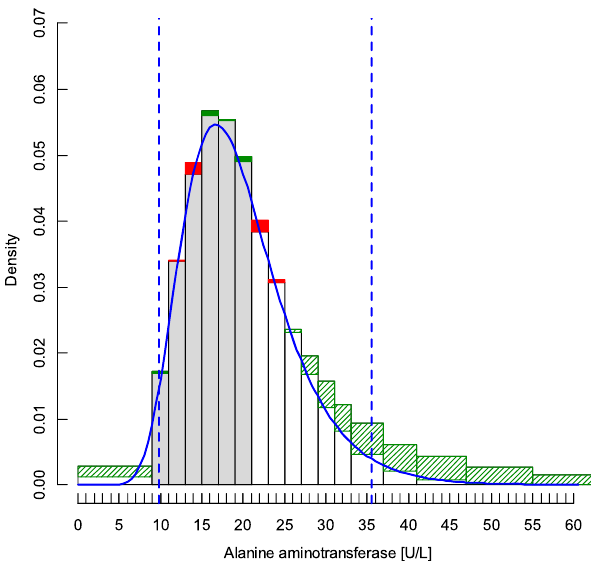
Figure 6: Histogram for alanine aminotransferase data in plasma (females, 70 – 79 years, n=11,056). Grey bins indicate the truncation interval, white bins lie outside the truncation interval. The blue PN distribution (PND) probability density curve is fitted by the truncated minimum chi-square (TMC) approach. Solid red and green rectangles indicate the differences between observed and expected counts which contribute to the χ 2 criterion.Redrectanglesindicatebinsinwhichtheexpectedcountis larger than the observed. These rectangles contribute to the χ 2 criterion inside and outside the truncation interval. Bins outside the truncation interval with expected count smaller than observed, marked by green hatched rectangles, do not contribute to the χ 2 criterion. The vertical dashed blue lines indicate the 2.5 and 97.5% RILs. Details of the calculation are given in ref. [31]. Observed bin values are white coloured areas + green areas or white coloured areas without red